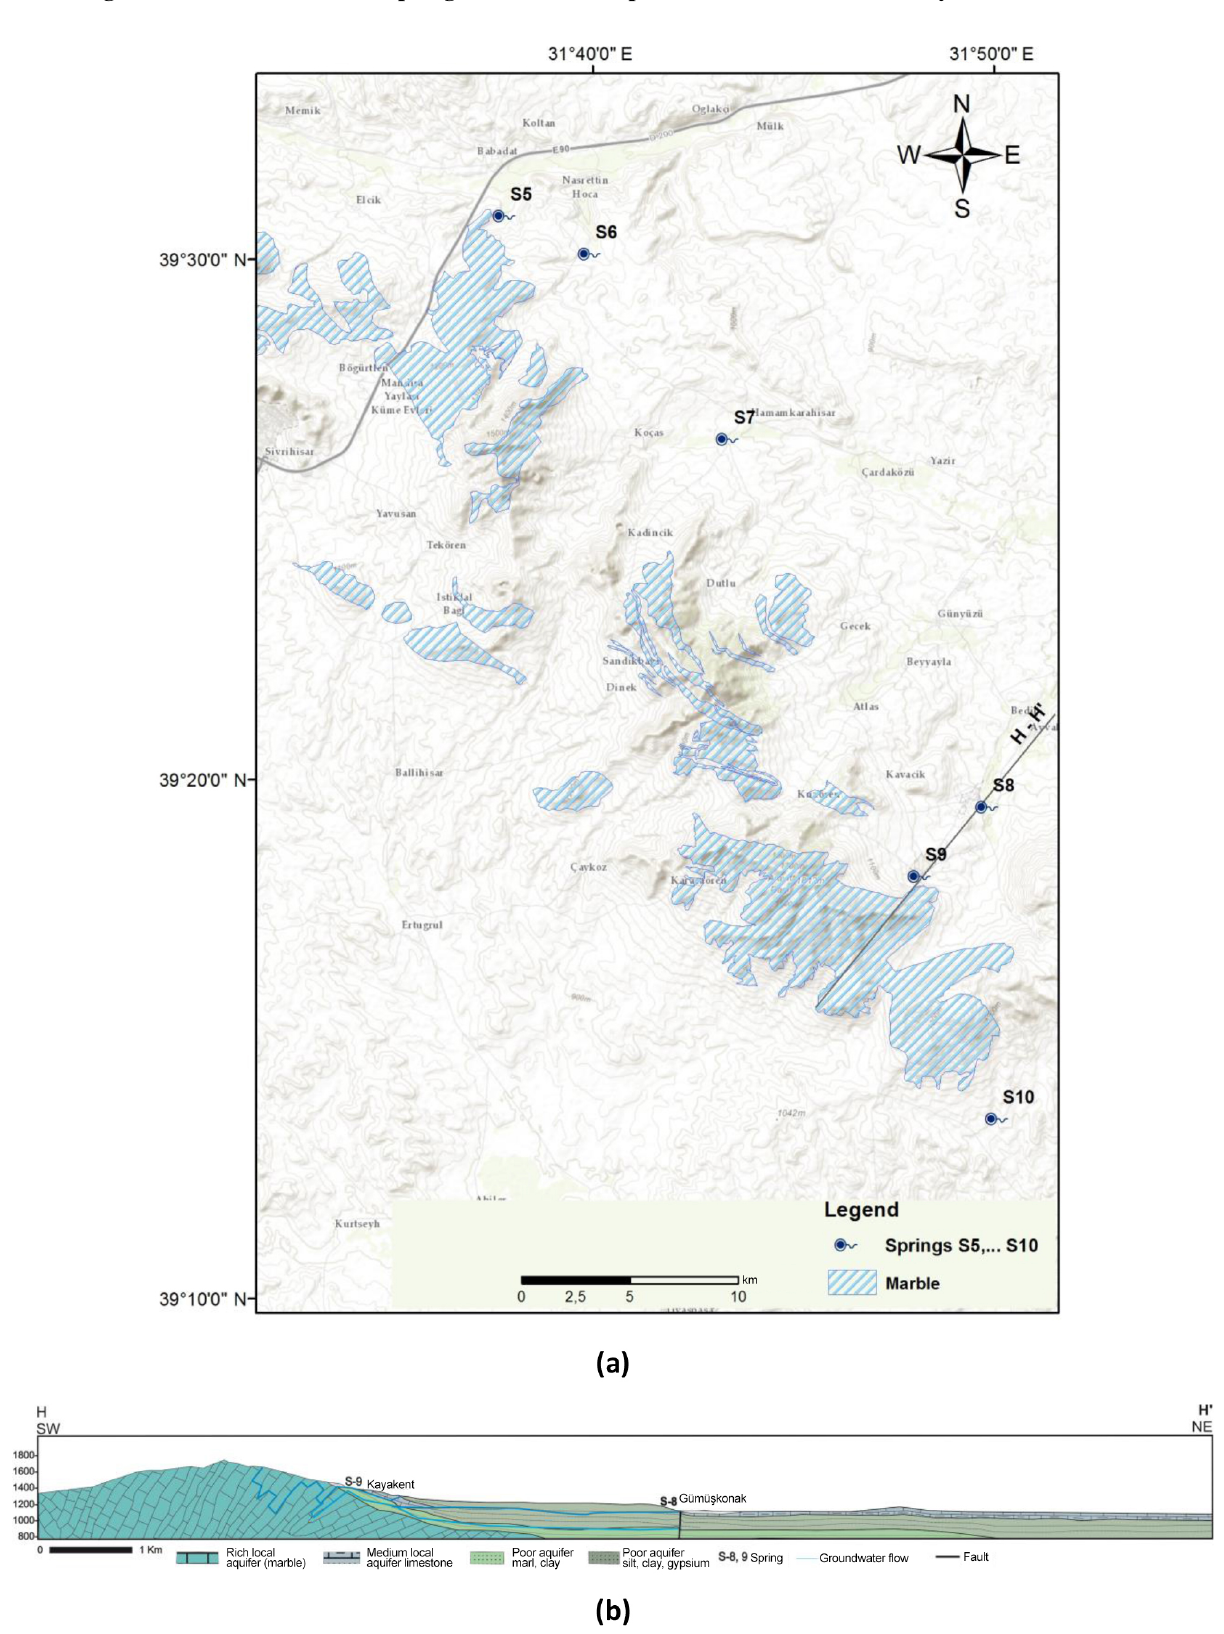
Figure 3. (a) Location map of Günyüzü marble, (b) the geological cross section of Günyüzü springs (Demiroglu, 2008). www.nat-hazards-earth-syst-sci.net/16/1473/2016/ Nat. Hazards Earth Syst. Sci., 16, 1473–1486,